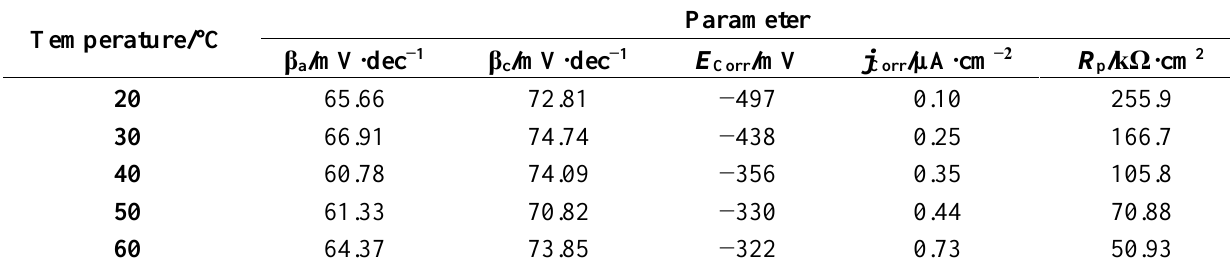
Figure 5. Potentiodynamic polarization behavior for γ-TiAl alloy in 3.5% NaCl solution at (1) 30 °C; (2) 40 °C; (3) 50 °C; and (4) 60 °C, respectively. Table 2. Potentiodynamic polarization parameters obtained for γ-TiAl alloy in 3.5% NaCl solutions after different temperatures.